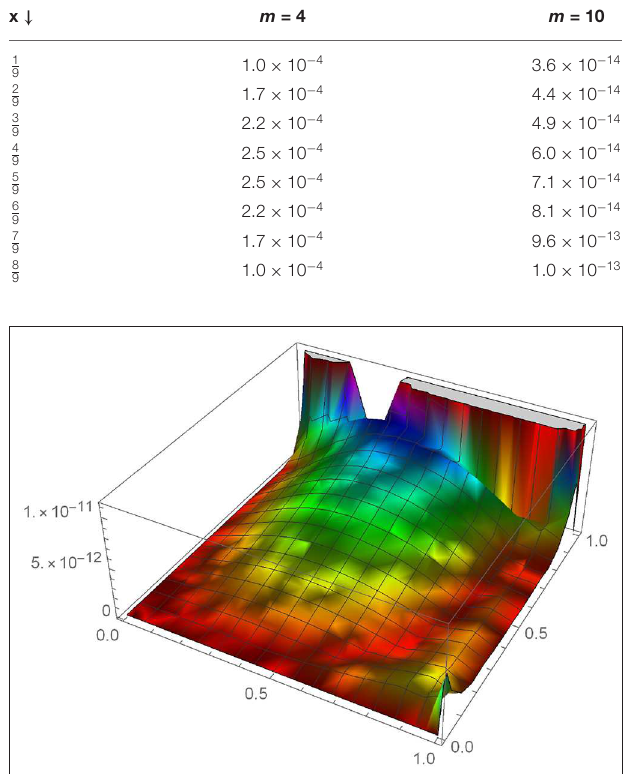
FIGURE 8 | 3D-plot of absolute error for m = 10.